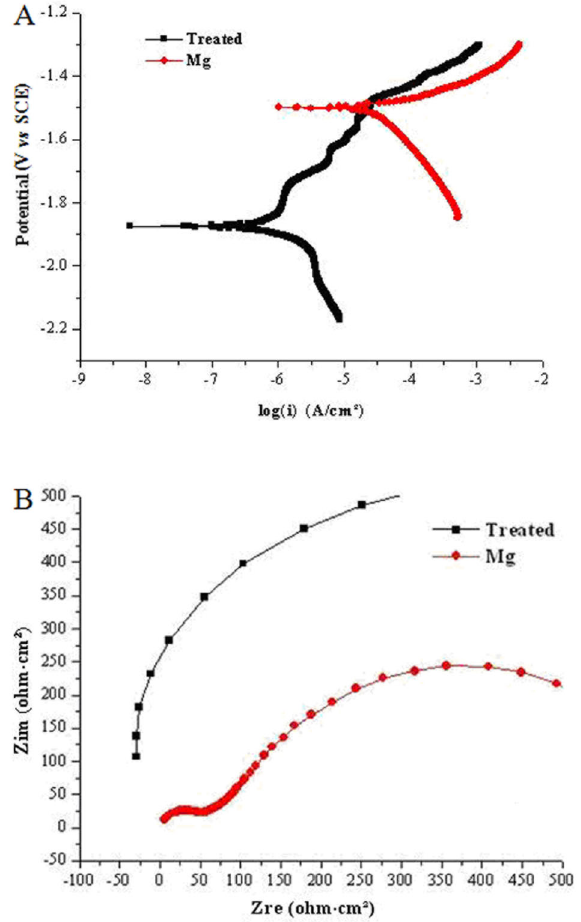
Figure 1. Electrochemical measurements. A , Polarization curves. B . Nyquist plots of Mg and MAO-treated Mg. MAO: micro-arc oxidation; Zre: real part of impedance; Zim: Imaginary part of